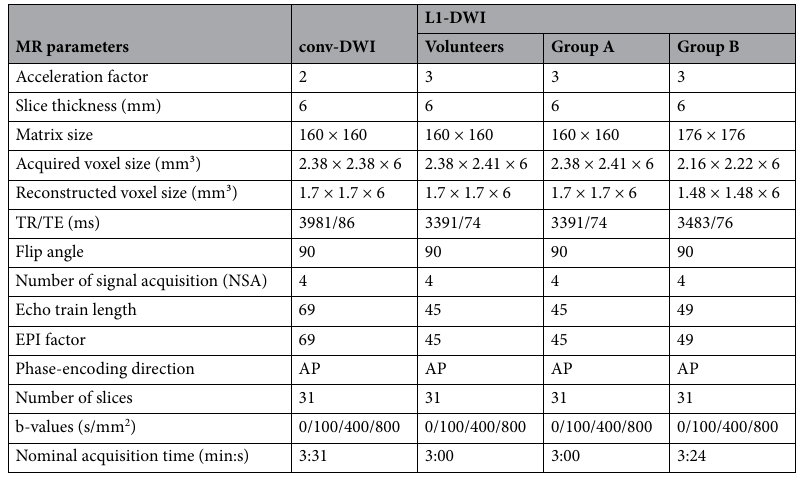
Table 1. MR imaging parameters of conv-DWI and L1-DWI based on single-shot EPI in this study. conv-DWI Single-shot EPI-based DWI with parallel imaging reconstruction, L1-DWI Single-shot EPI-based DWI with L1-regularized iterative